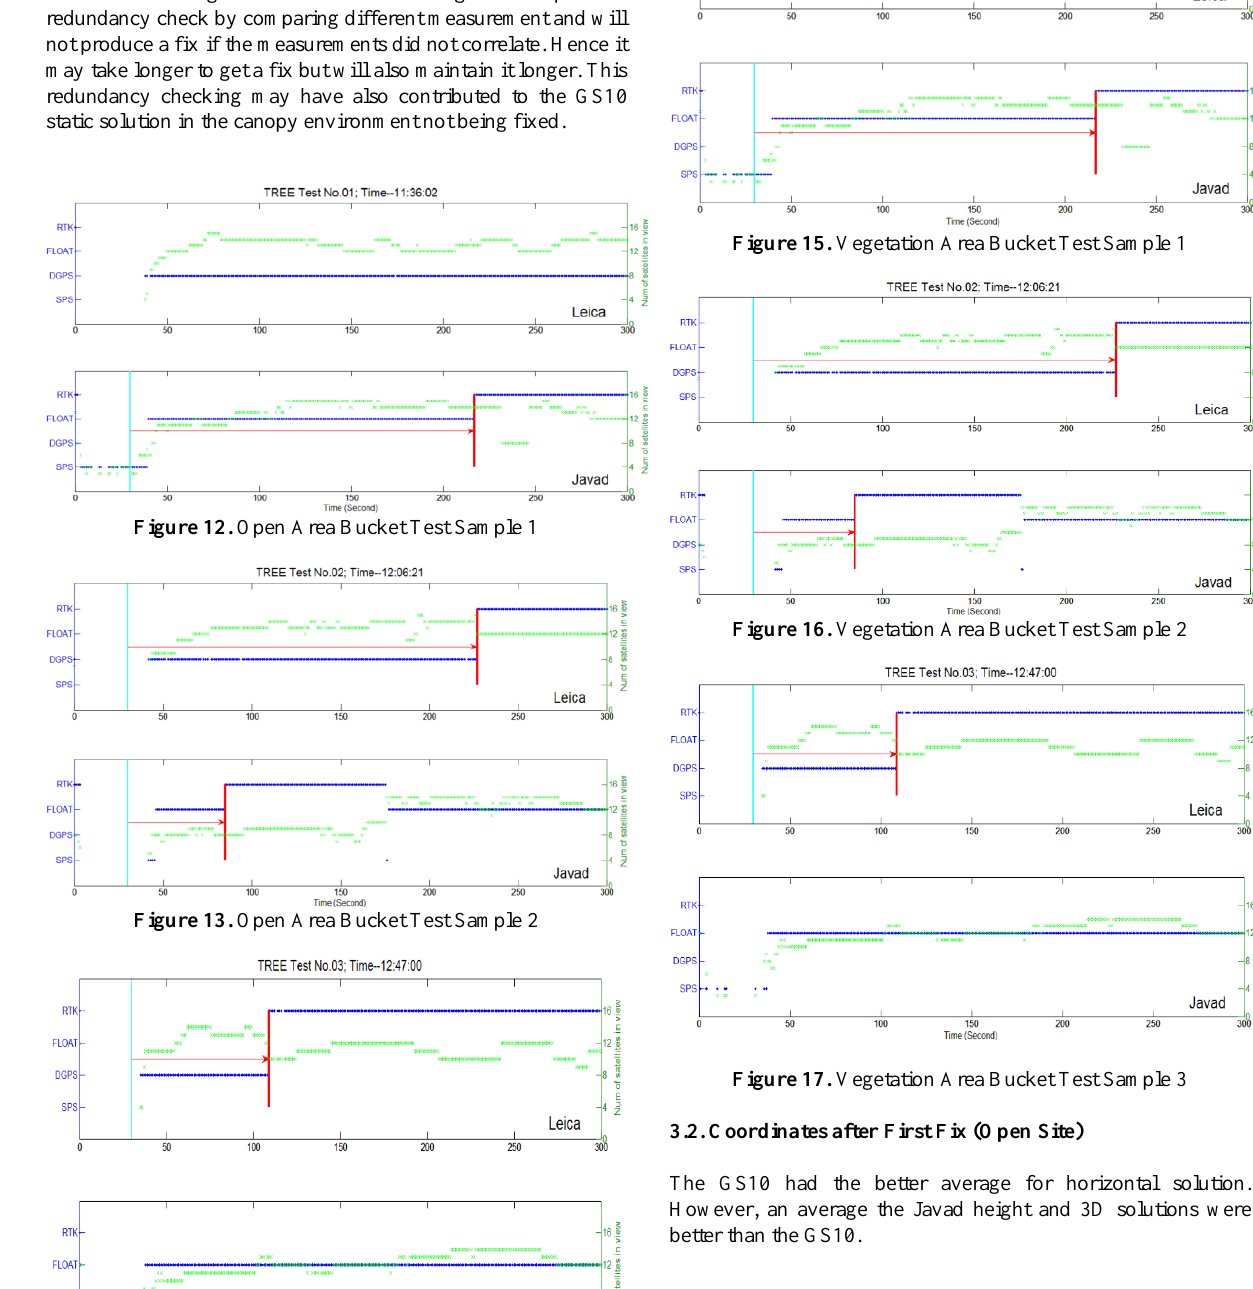
Figure 14. Open Area Bucket Test Sample 3